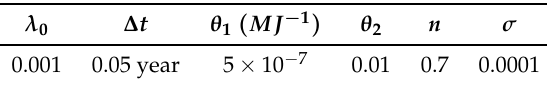
Table 2. Degradation model